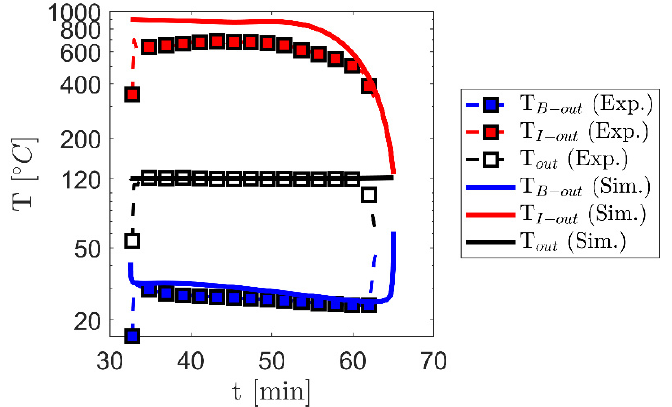
Figure 11. Transient temperature characteristics at the outlet of the storage inventory (T I − out ), the bypass path (T B − out ) and the storage system (T out ).